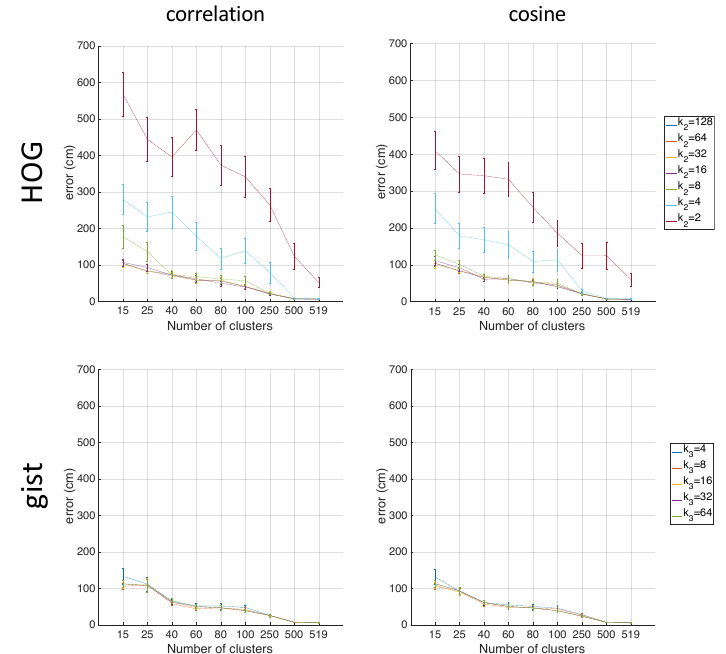
Figure 18. Results of the localization process with HOG and gist used to describe the representatives of the clusters and the test images: average localization error (cm) vs. number of clusters. Freiburg